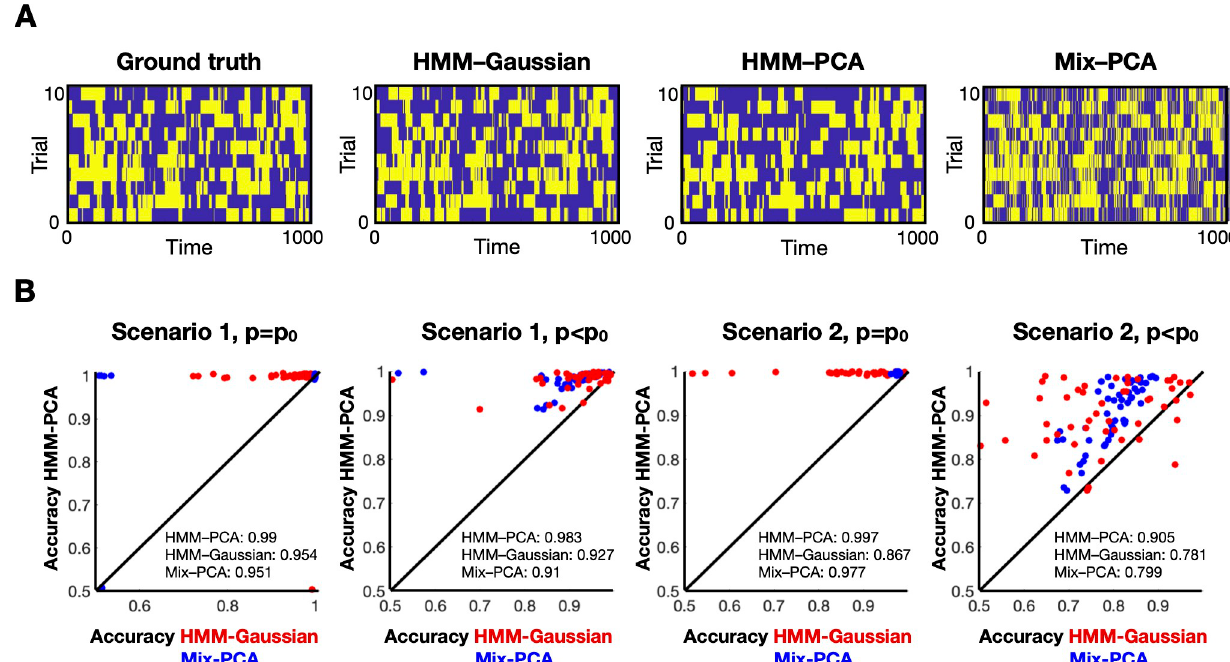
Fig 2. HMM-PCA outperforms the HMM-Gaussian and Mix-PCA approaches on synthetic data. A . Example of how the different models recover the ground-truth state time courses. B . Comparative accuracy between HMM-PCA (Y-axis), HMM-Gaussian (X-axis, red) and Mix-PCA (X-axis, blue). Each dot represents one repetition of the simulations. Accuracy is measured in terms of how well each method recovered the ground-truth state time courses. Permutation-based statistical testing revealed that HMM-PCA was always significantly more accurate than the other approaches (p < 0.001).